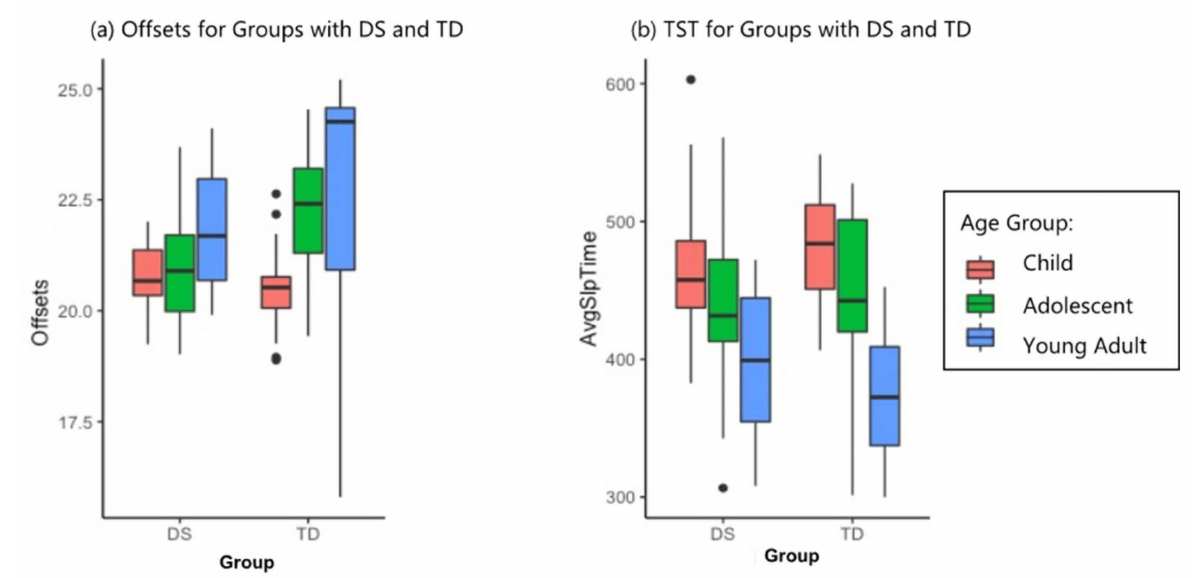
Figure 2. Phase timing and average total sleep time estimates. ( a ) Average offsets (time of falling asleep) by group and age. The adolescent phase shift at the onset of puberty is visible in the TD group, where the mean offset was 1 h 45 min later for adolescents than children. Adolescents with DS, on the left, fell asleep only 15 min later than children with DS. ( b ) Total sleep time (TST) by group and age, illustrating the similar amounts of TST between the two groups at each